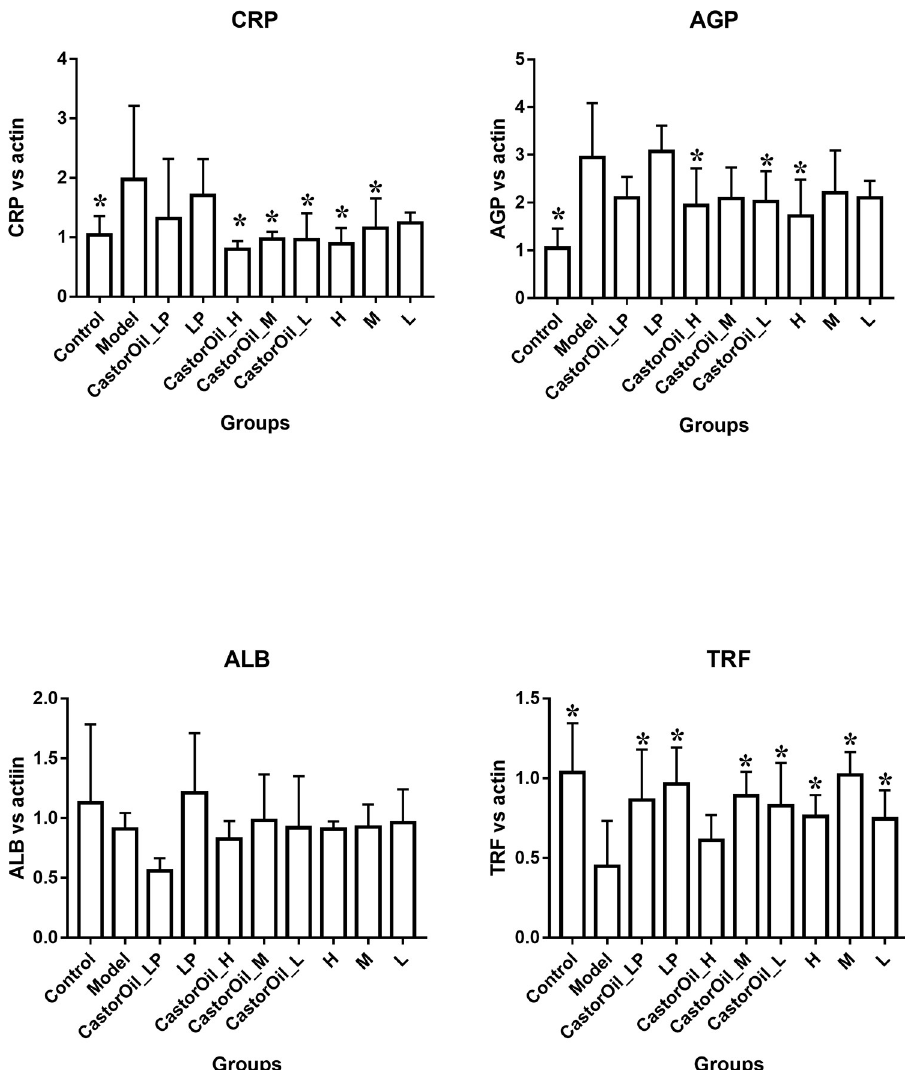
Fig 3. The expression of APPs mRNAs in the liver. Changes in acute phase proteins (APPs) mRNA expression in the liver of mice after castor oil administration. Castor oil increased the mRNA expression of CRP and AGP, but decreased that of TRF. And FengLiao restored them to normal levels. LP (loperamide), H (high dose of FengLiao), M (medium dose of FengLiao), L (low dose of FengLiao). 1 g/ml FengLiao (H), 0.5 g/ml FengLiao (M), 0.25g/ml FengLiao (L) and 5mg/kg loperamide were pretreated in CastorOil_H, H, CastorOil_M, M, CastorOil_L, L, CastorOil_LP, LP groups once a day for three days respectively. 30 min after the last drug administration, 0.5ml castor oil was used to induce diarrhea in CastorOil_H, CastorOil_M, CastorOil_L and CastorOil_LP groups for 4 h and the transcriptional level of expression for APPs was determined by qRT-PCR for CRP, AGP, ALB and TRF. Bar graphs show quantitative results normalized to β -actin mRNA levels. X axis represent groups’ name. Column represents the mean ± SD of five mice. � p < 0.05 versus model group, ANOVA Test.